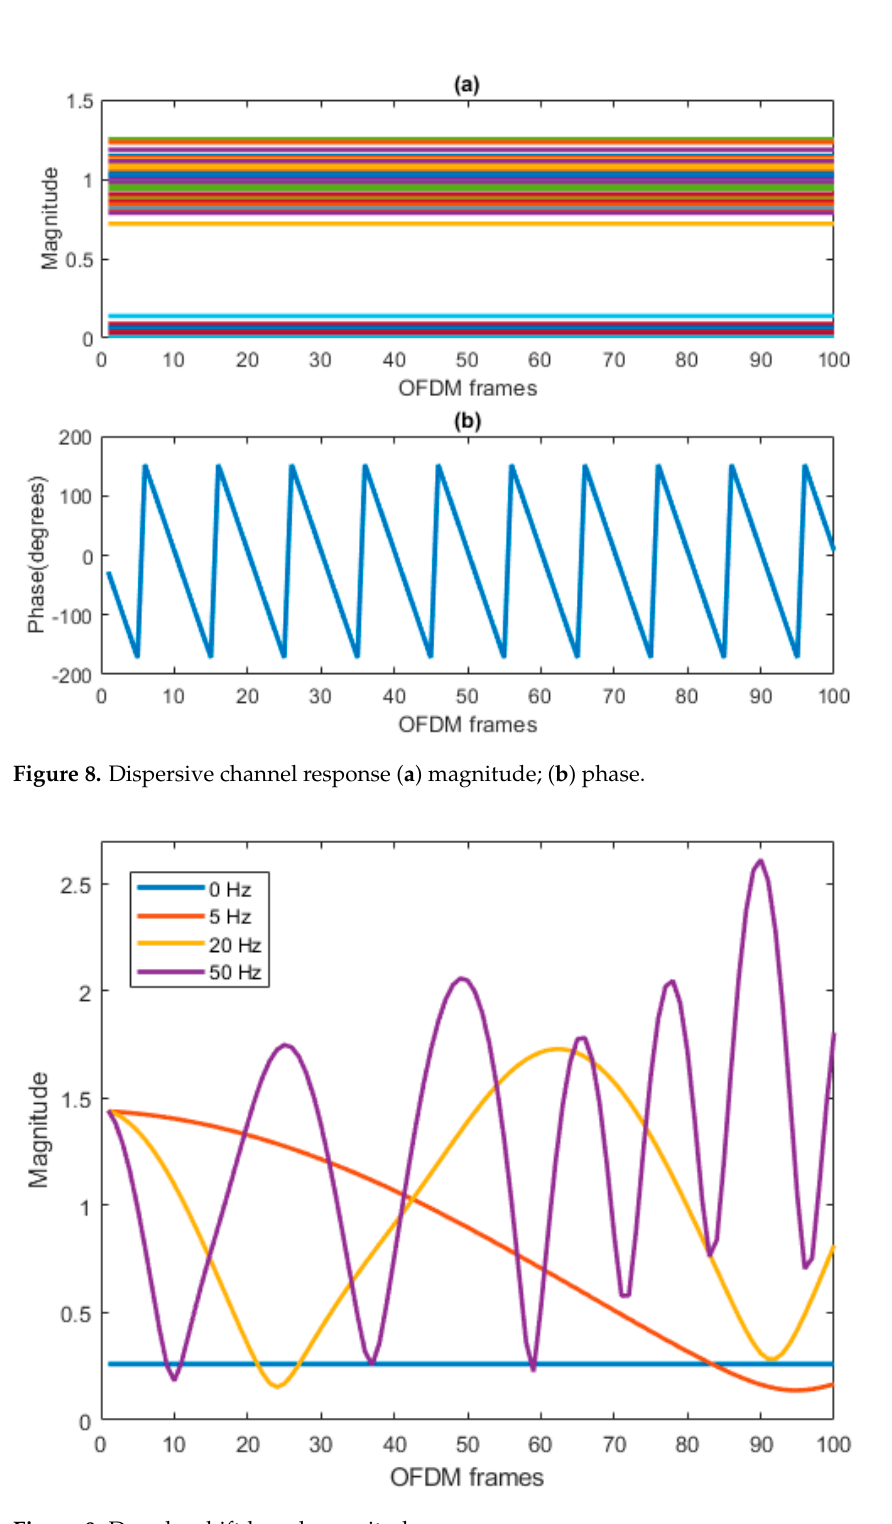
Figure 9. Doppler shift-based magnitude response.